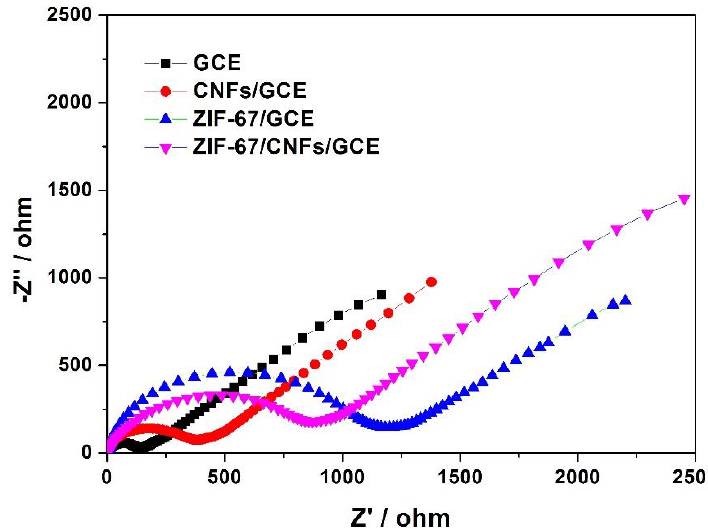
Figure 4. Nyquist plots for bare GCE, CNFs/GCE, ZIF-67/GCE and ZIF-67/CNFs/GCE in a solution of 0.1 M KCl containing 5 mM Fe(CN) 6 3−/4− with the potential of 0.2 V, the frequency range from 0.01 Hz to 100000 Hz and signal amplitude of 5 mV.